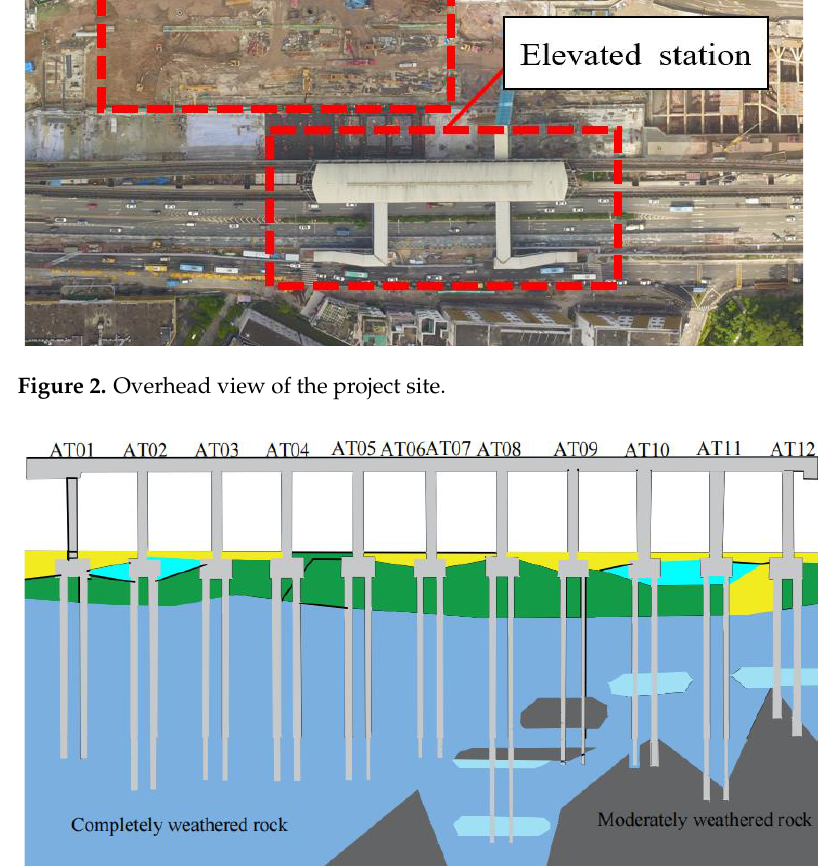
Figure 3. Sectional view of viaduct pile foundation.